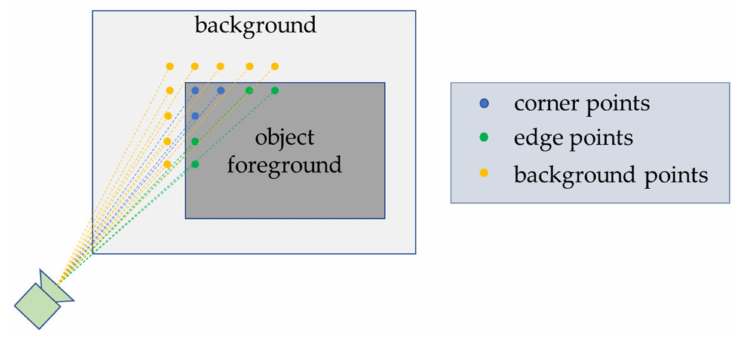
Figure 4. Distribution of salient